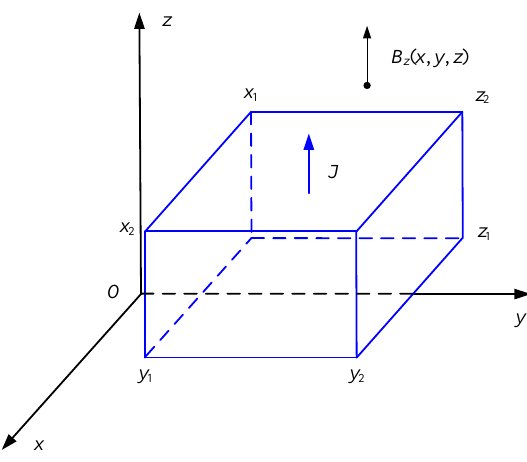
Figure 3. Dimensions for calculation of magnetic flux density at point ( x , y , z ).